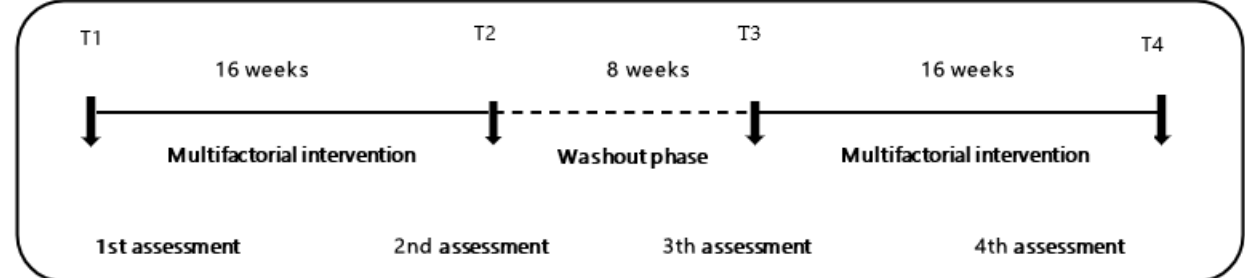
Figure 2. Chronological order of multifactorial interventions study design. T1 to T2 (elastic-band exercise, 16 weeks, 8 weeks), T2 to T3 (wash-out), T3 to T4 (multicomponent exercise, 16 weeks).